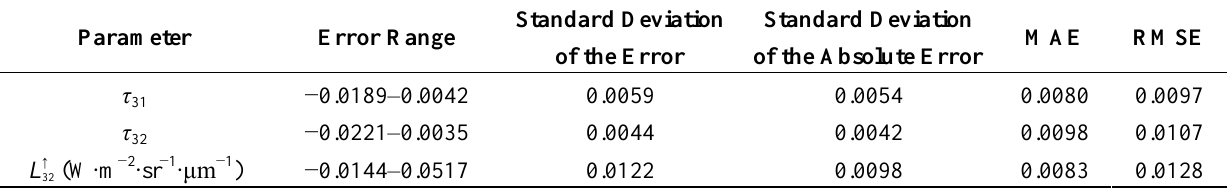
Table 3. Statistics on the errors of the calculated τ radiosonde profiles collected during the field